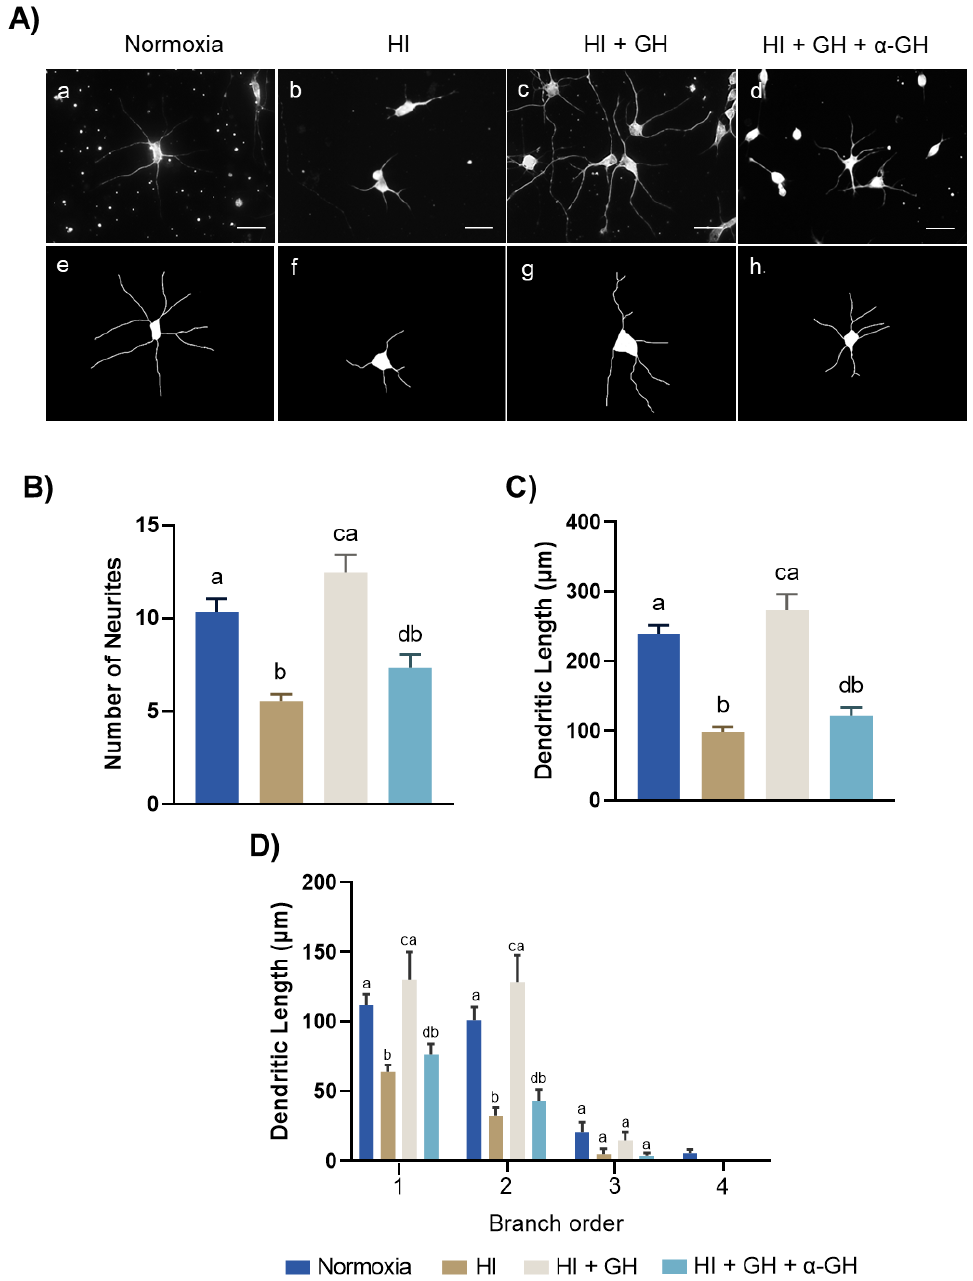
Figure 5. Effect of growth hormone (GH) upon neurite outgrowth after a hypoxic–ischemic (HI) injury. ( A ) Representative images of pallial neurons stained with β -III-tubulin under each experimental condition: (a) normoxia, (b) HI, (c) HI + 10 nM GH, (d) HI + 10 nM GH + 1:20 dilution of specific anti-cGH antibody ( α -GH). Scale bar: 50 µ m. Schematic drawings of neurons stained with β -III-tubulin used for morphometric analysis, in: (e) normoxia, (f) HI, (g) HI + GH, (h) HI + GH + α -GH. ( B ) The number of neurites was evaluated in 10 individual neurons for each group. ( C ) For dendritic length analysis, individual neurons were selected and drawn using the Simple Neuro Tracer plug-in of FIJI-ImageJ software. ( D ) Branching dendritic analysis realized on pallial neurons under each experimental condition. Bars represent mean ± SEM (from 3 independent experiments in duplicate; n = 6 cultures per group). Groups with different letters are significantly different by one-way ANOVA with Tukey’s post hoc test ( p < 0.05).